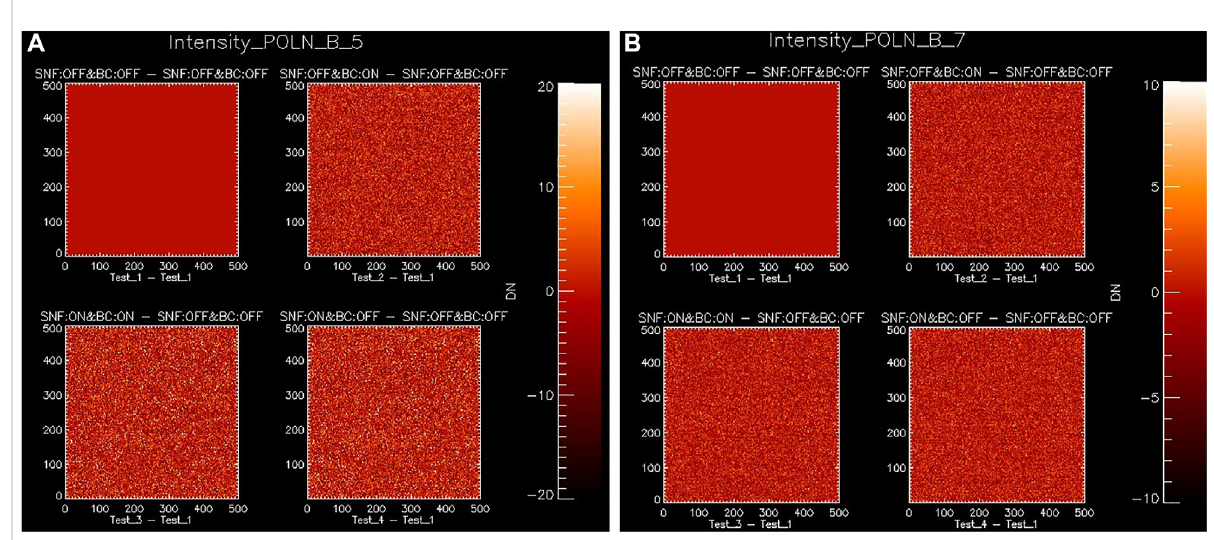
FIGURE 4 2D map of the in fl uence of SNF and BC on pixels. The images of the data obtained with the SNF and/or BC ON was subtracted from the image obtained with the SNF and BC OFF. (A) represents the analysis for Block 5 (Global and Cooling OFF) and (B) for Block 7 (Rolling and Cooling OFF). All images have the same exposure time (9 × 10 − 6